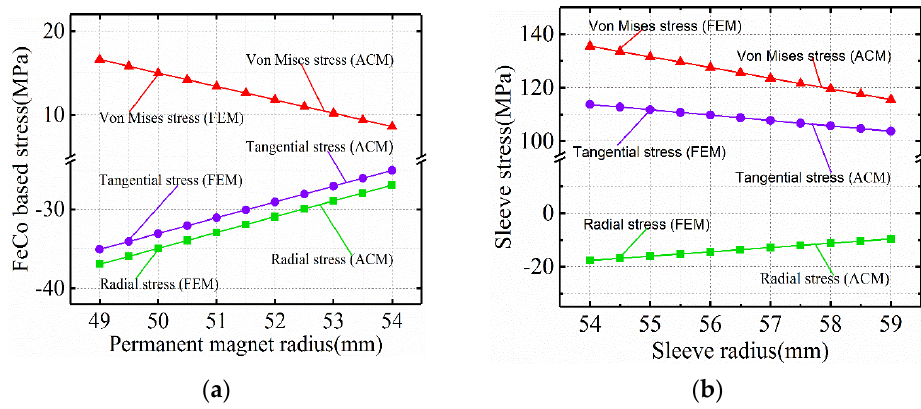
Figure 4. Von-Mises stress distribution of NdFeB PM and sleeve under steady condition.